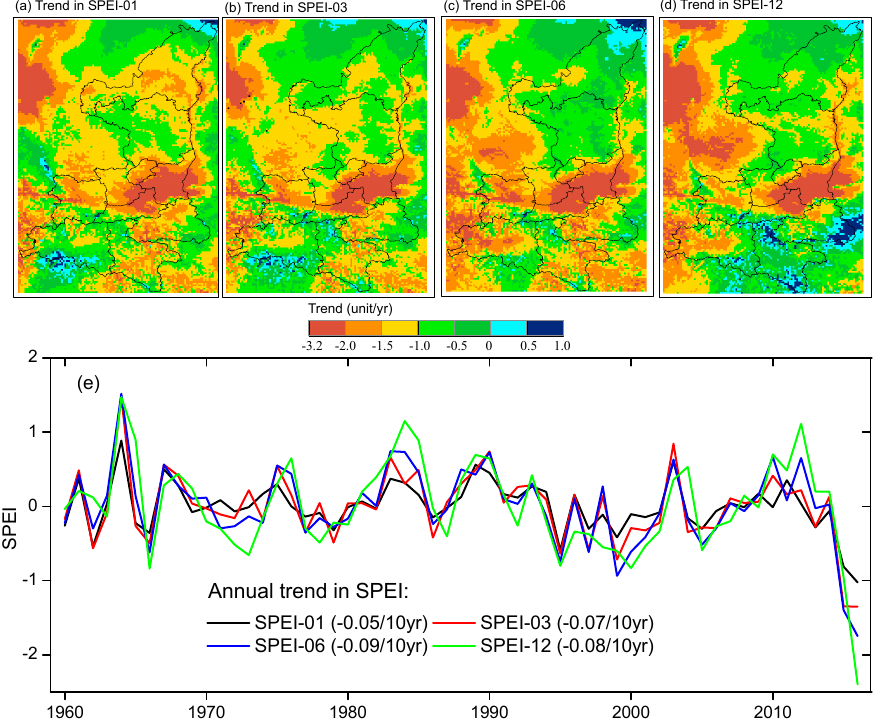
Figure 5. Spatial patterns in the annual trend of SPEI at 1-, 3-, 6-, and 12-month lags ( a – d ), and inter-annual variations and annual trends in SPEI time series at four typical timescales ( e